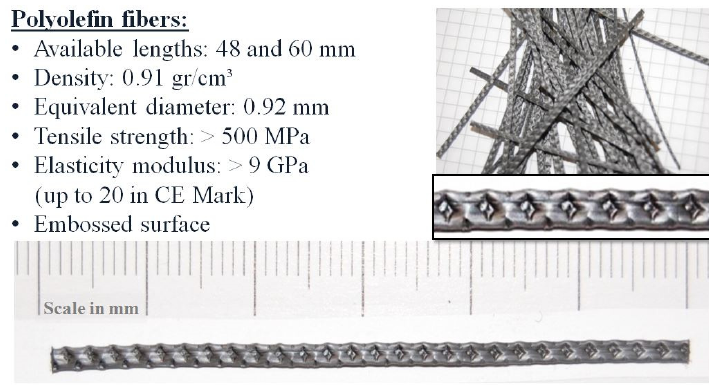
Figure 1. Properties and visual aspect of polyolefin macro-structural